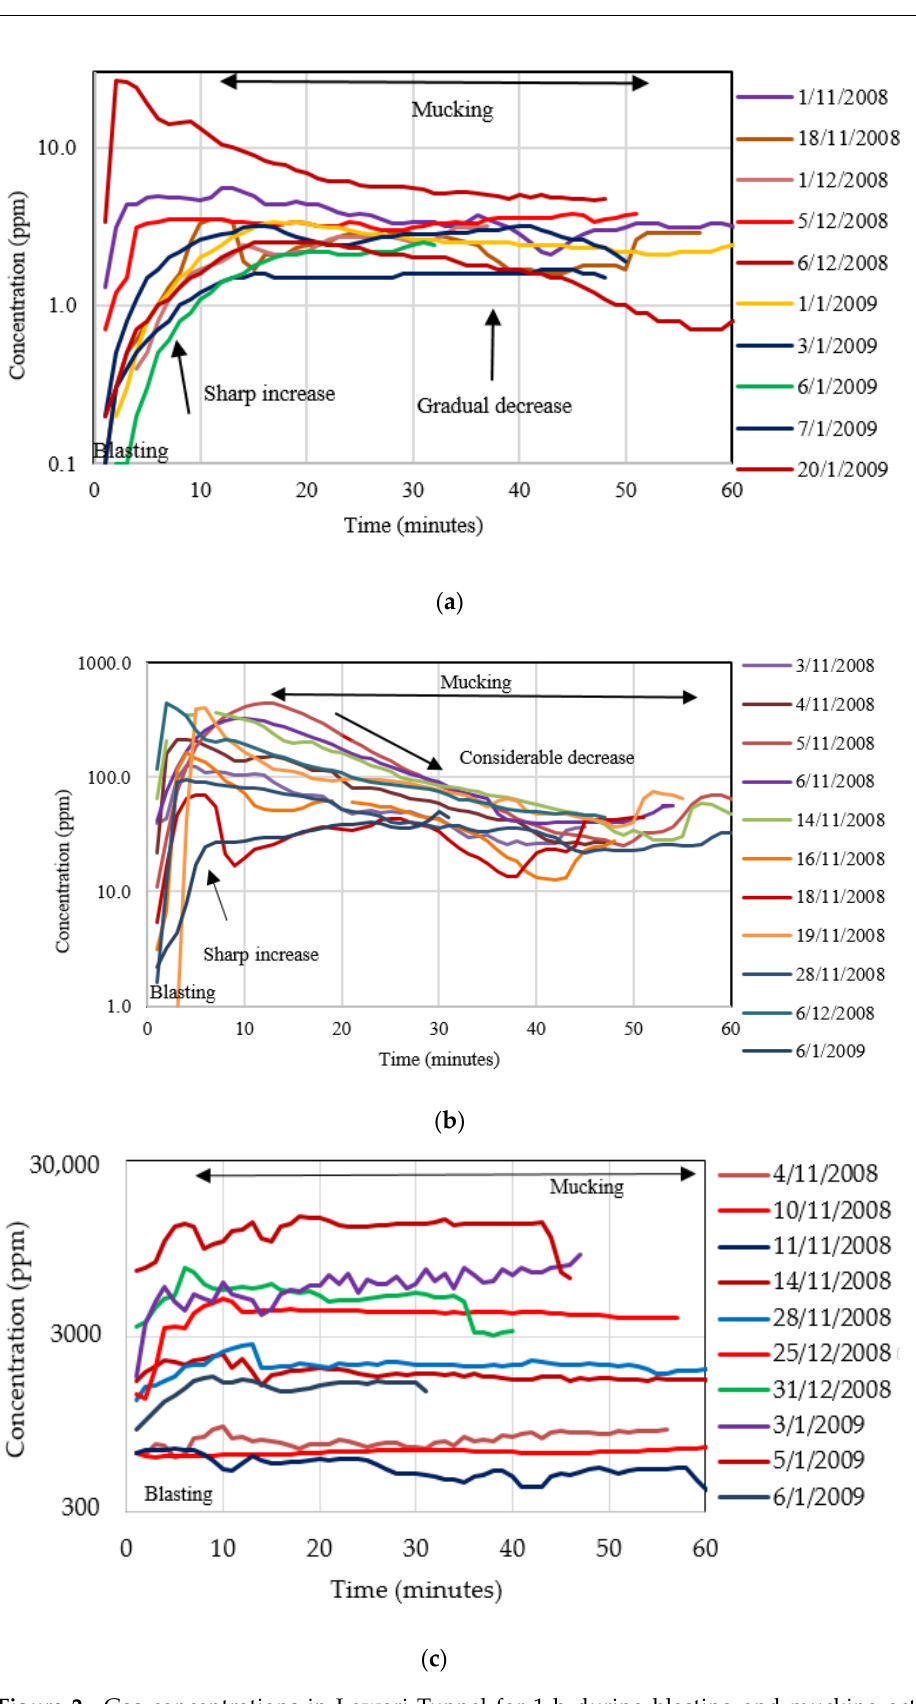
Figure 2. Gas concentrations in Lowari Tunnel for 1 h during blasting and mucking activities. ( a ) Concentration of nitrogen oxide; ( b ) concentration of carbon monoxide; ( c ) concentration of carbon dioxide.